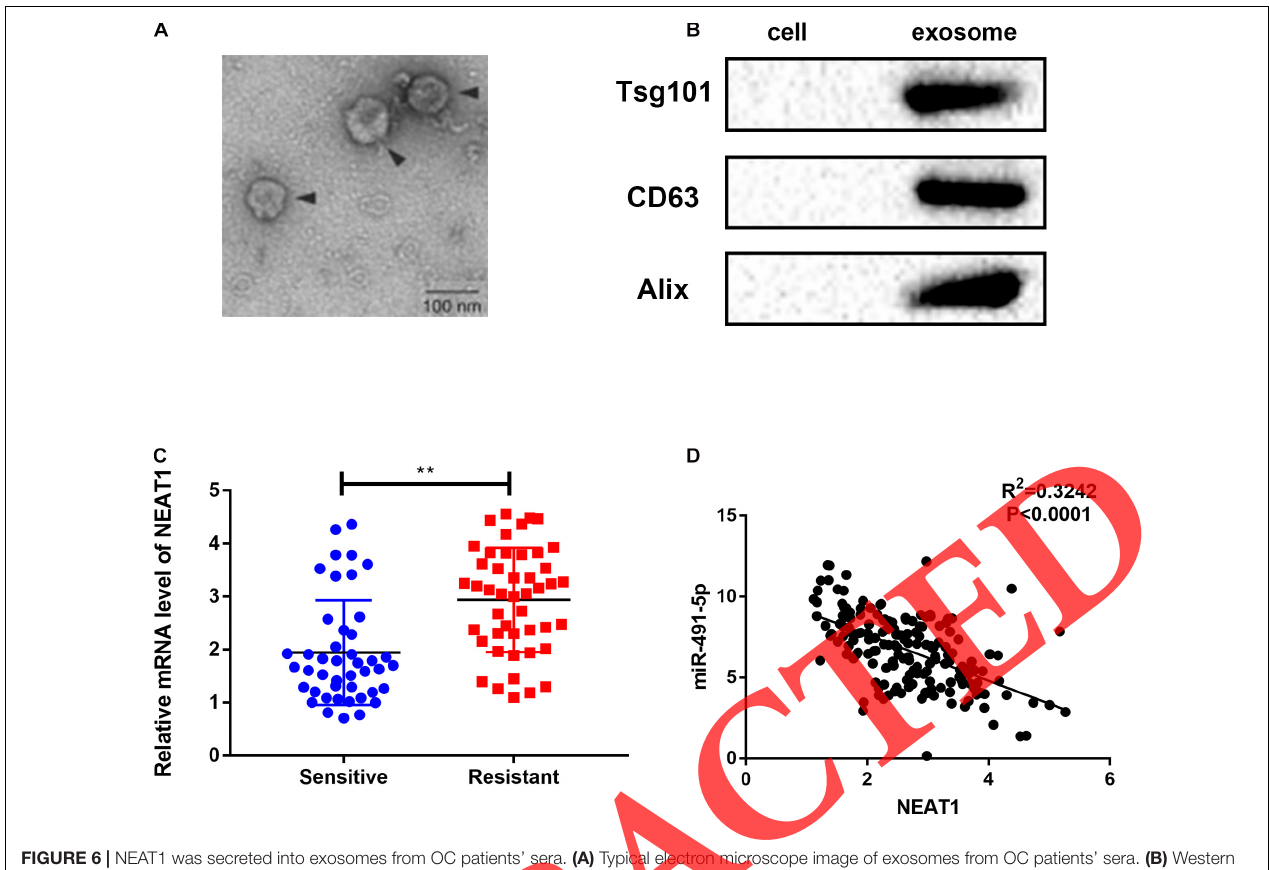
FIGURE 6 | NEAT1 was secreted into exosomes from OC patients’ sera. (A) Typical electron microscope image of exosomes from OC patients’ sera. (B) Western blotting for biomarkers of exosomes from purified serum exosomes. (C) QRT-PCR for the abundance of NEAT1 in serum exosomes, and NEAT1 levels in sera. (D) Negative association between NEAT1 and miR-491-5p expressions in exosomes extracted from OC patients’ sera. ** p <